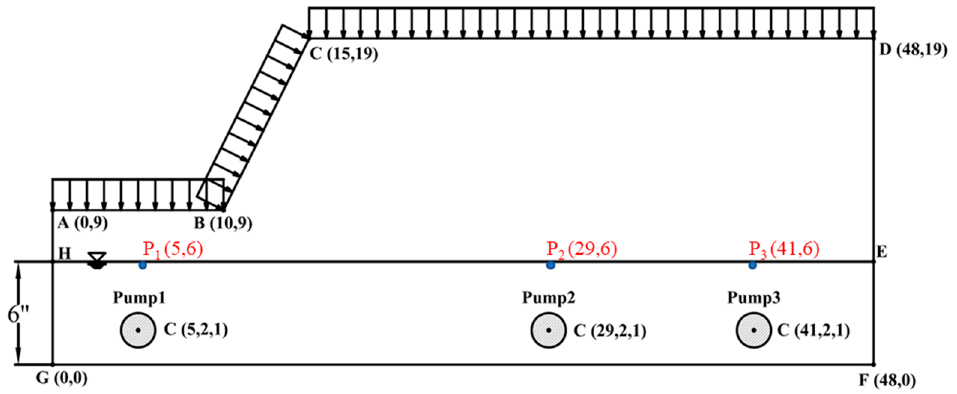
Figure 2. Cross ‐ section of soil slope equipped with pumps subjected to rainfall (Units: Inch). Figure 2. Cross-section of soil slope equipped with pumps subjected to rainfall (Units: